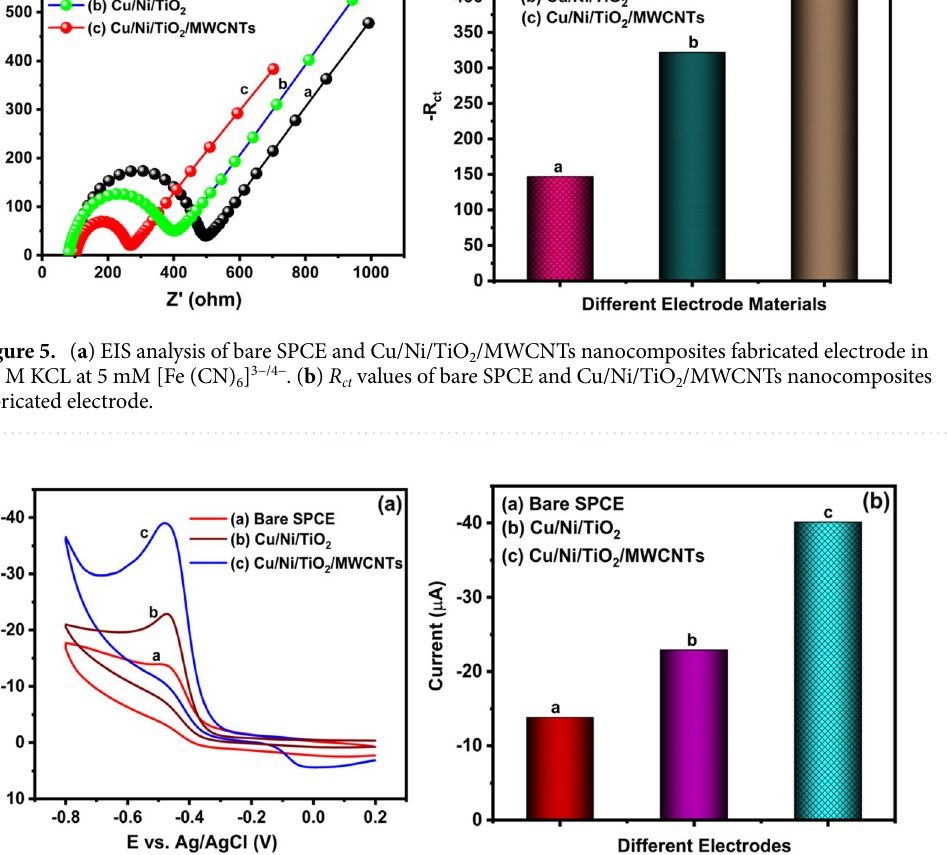
Figure 6. ( a ) CV plot for the electrocatalytic activity of bare SPCE and Cu/Ni/TiO 2 /MWCNTs nanocomposites fabricated electrode, and ( b ) bar diagram of bare SPCE and decorated SPCE current